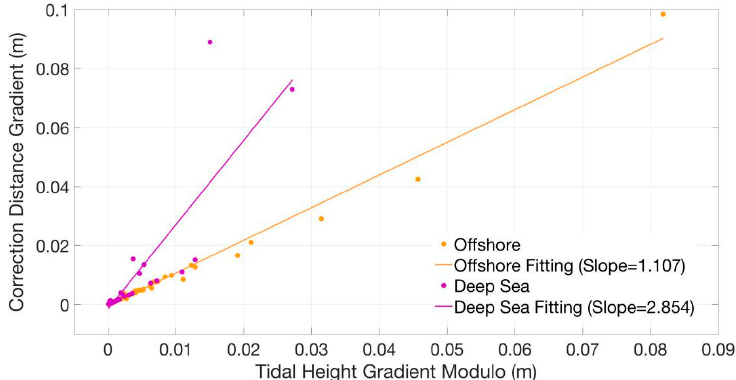
Figure 7. Tidal height gradient modulos and the corresponding tidal positioning correction gradient modulos of the deep sea segments.